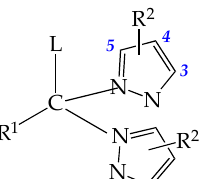
Figure 1. General C-scorpionate structure: homoscorpionate (L = pyrazolyl) or heteroscorpionate (L ≠ pyrazolyl).